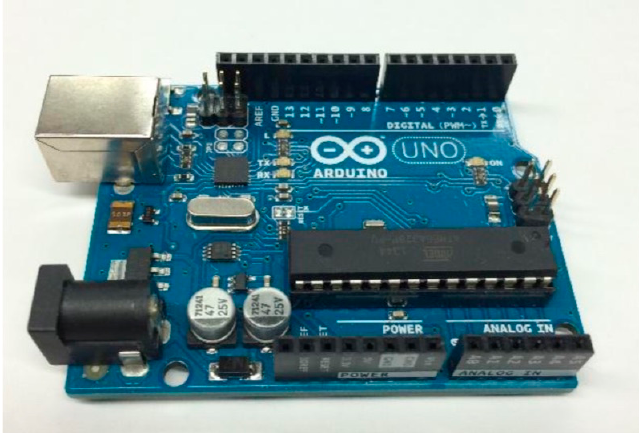
Figure 3. Arduino UNO R3. Table 2. Arduino UNO R3 specifications.